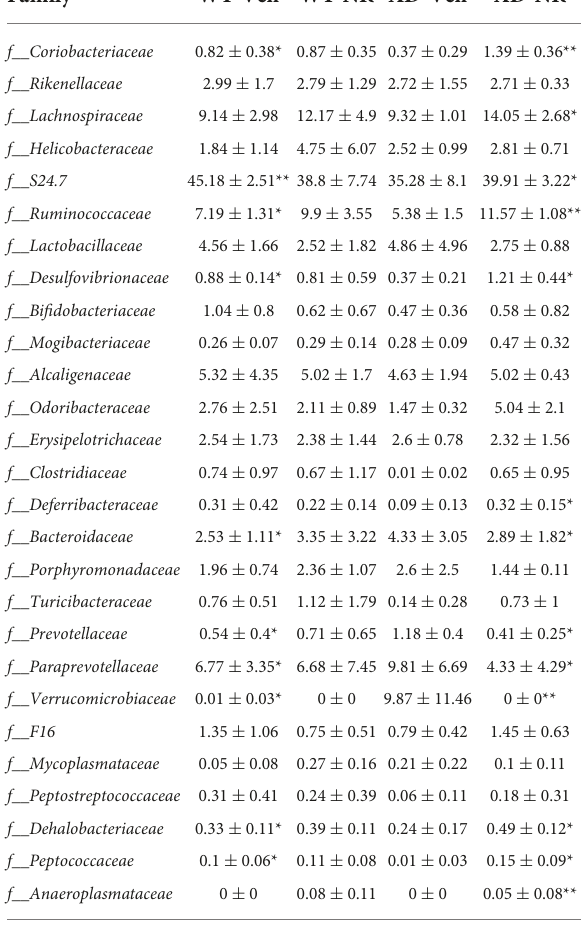
TABLE 2 The relative abundance (%) of species at family level.